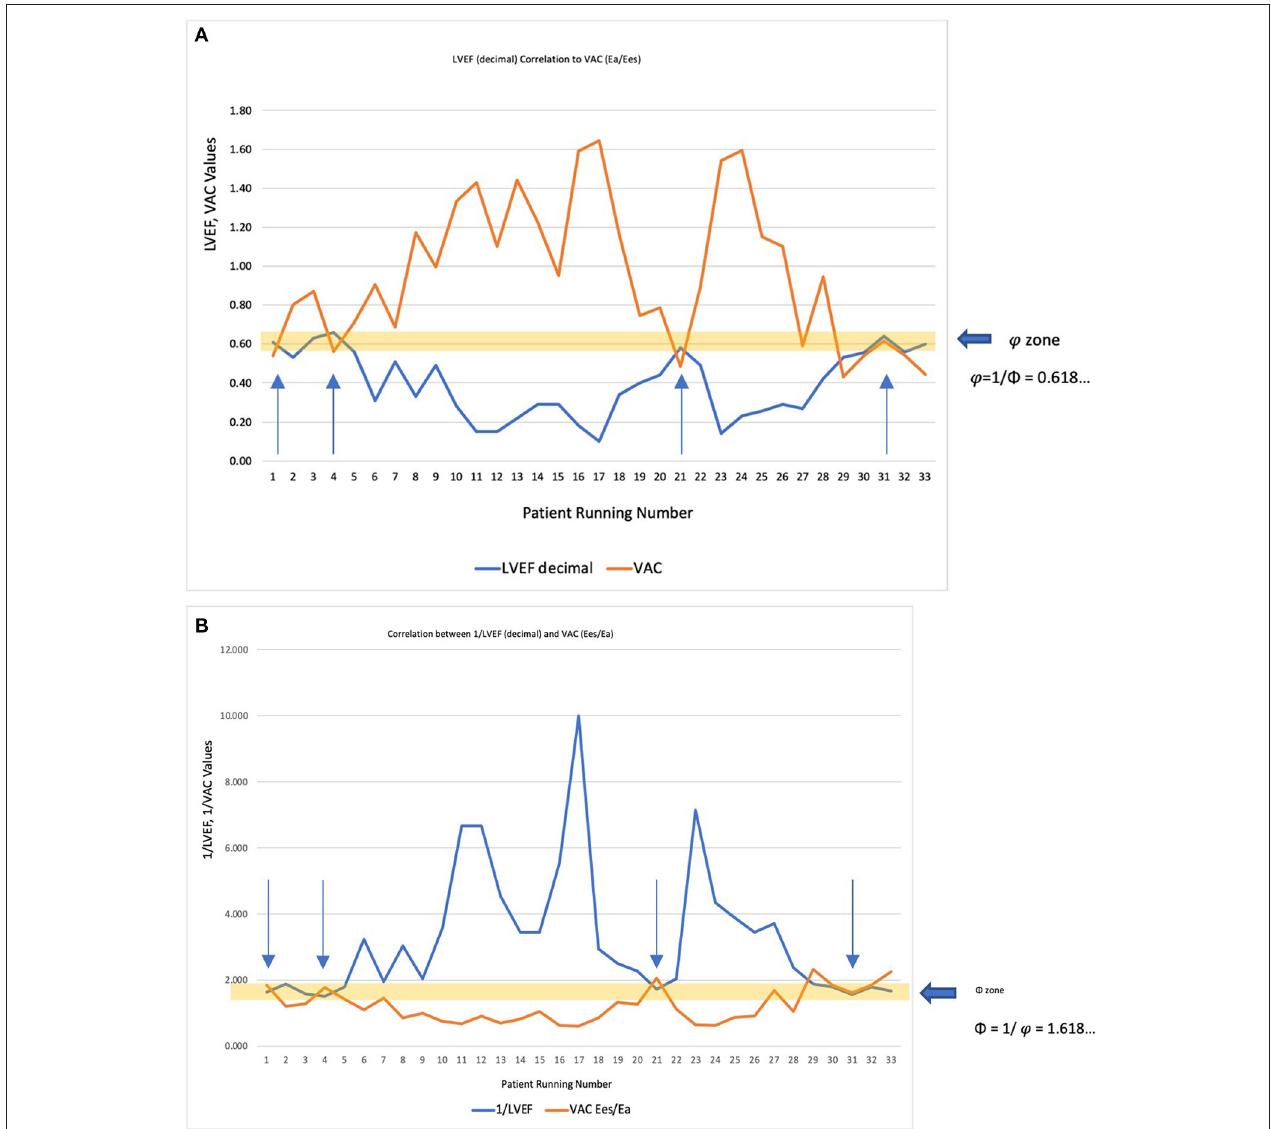
FIGURE 3 | (A) LVEF decimal ( < 1) correlated to the most used VAC formula (Ea/Ees). The “ ϕ zone” is the narrow interval very close to the optimal value ( ϕ 0.618…), where LVEF VAC 0.62. The arrows indicate the four patients within this interval. (B) Considering that ventricular elastance (Ees)/arterial elastance ≈ = = (Ea) is the reciprocal ratio of the Ea/Ees, the correlation was made with 1/LVEF (decimal). The “ Φ zone” will be therefore in the close vicinity of 1.618 ( Φ ), where 1/LVEF Ees/Ea 1.618. The arrows indicate the same four patients within this = ≈